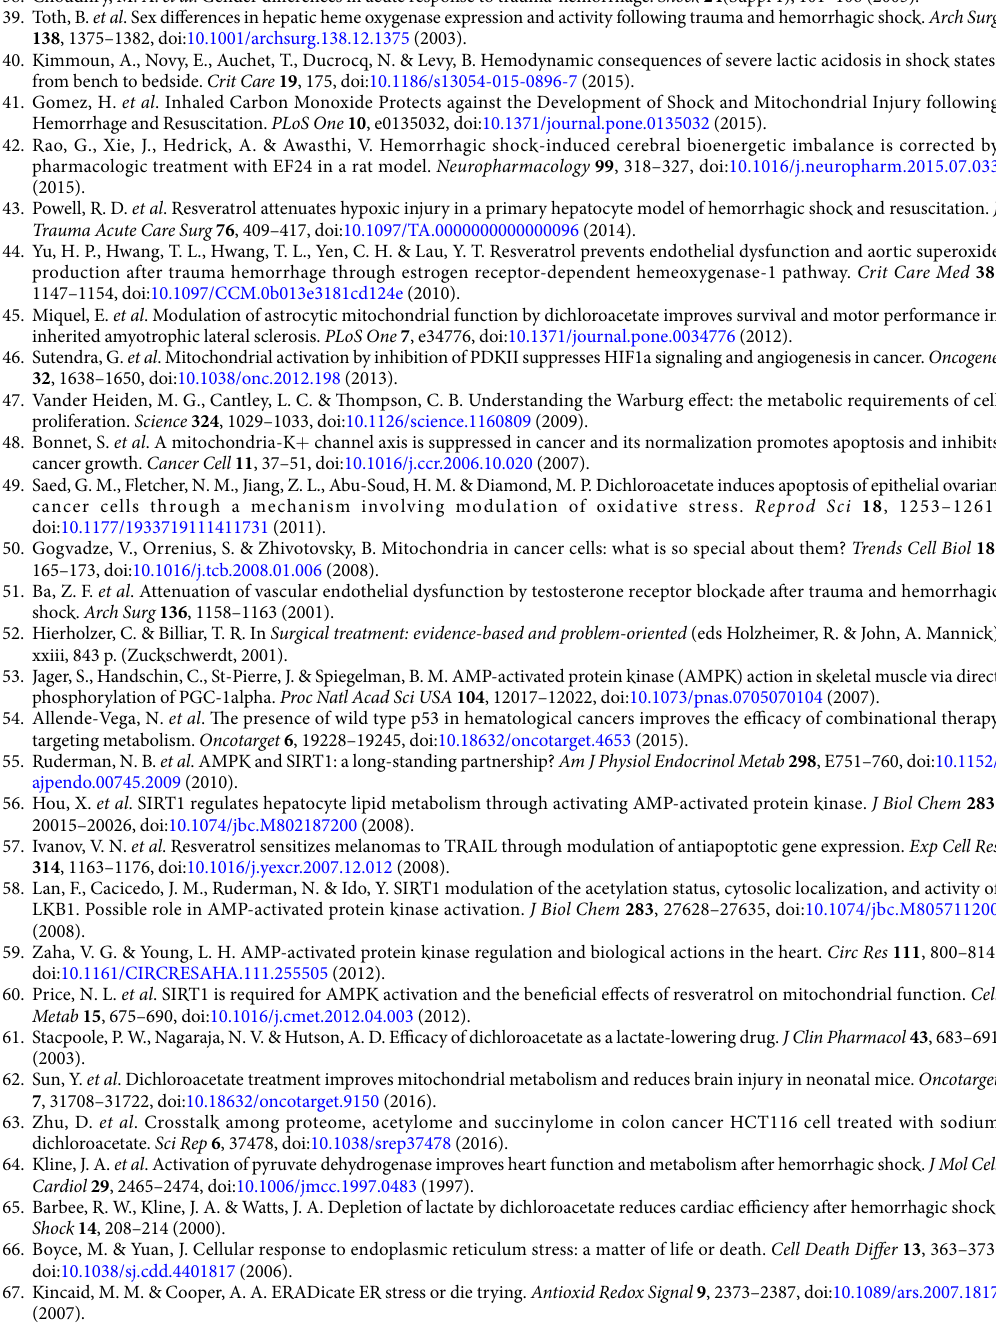
Figure 6: M.W. Experiments for Figure 7: H.A.T. Wrote the manuscript: K.S., R.W.C., M.P.D. and R.R. All authors reviewed the manuscript. Additional